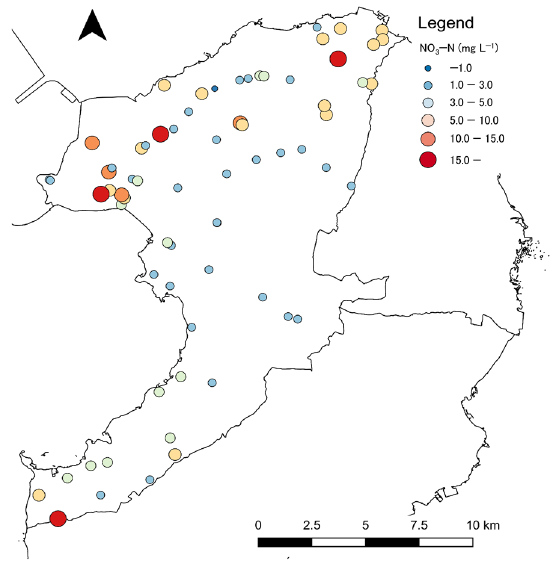
Figure 6. Distribution of nitrate concentration in groundwater. Table 2. Correlation matrix for eight dissolved ions.